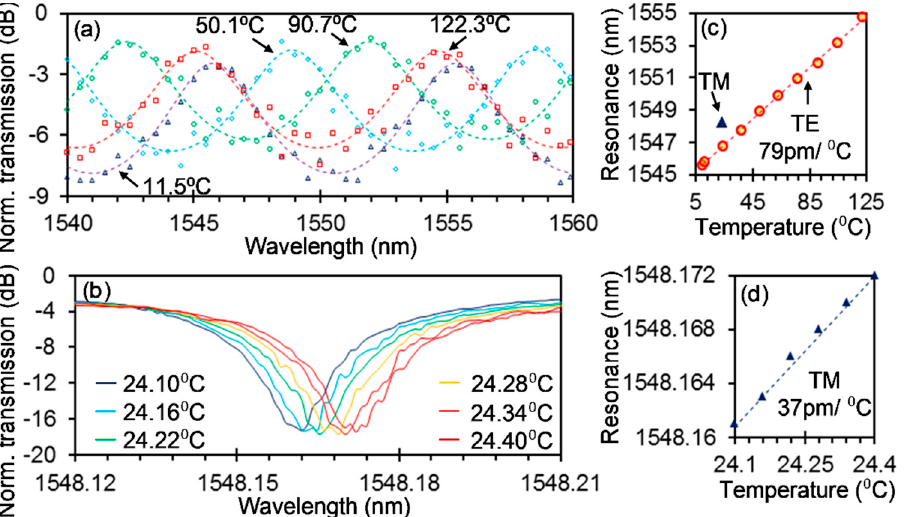
Figure 5. The fabricated silicon photonic polarization multiplexing sensor for temperature sensing. Measured spectra at different temperatures for the TE ( a ) and TM ( b ) modes. For the TE mode, the measurement results are shown with open markers, and the fitting curves are shown with dashed lines, while for the TM mode, only the measurement results are shown. Resonant wavelength with respect to the temperature for the TE ( c ) and TM ( d ) modes. Linear fittings (dashed lines) and slope values are also shown in ( c , d ).